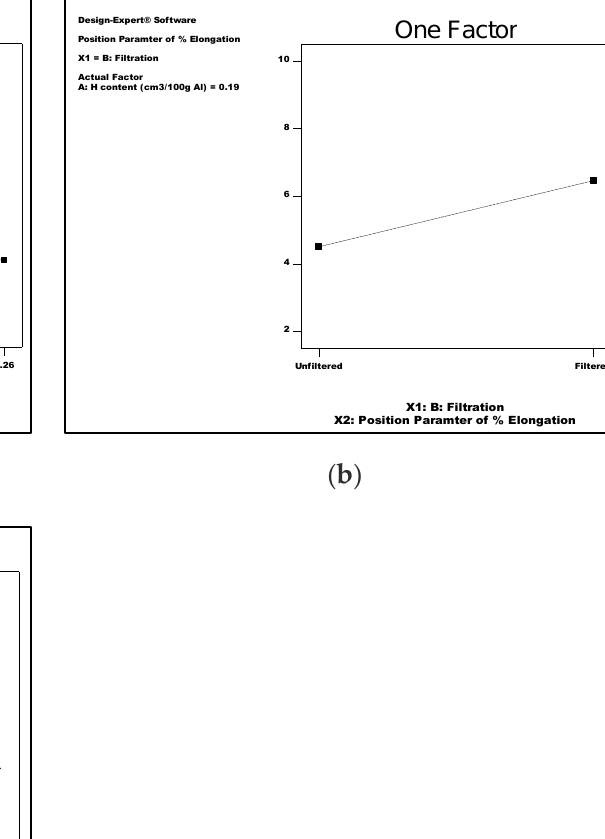
Figure 6. Influence of ( a ) hydrogen level, ( b ) filtration ( c ) the interaction between hydrogen level and filtration on x 0)UTS.